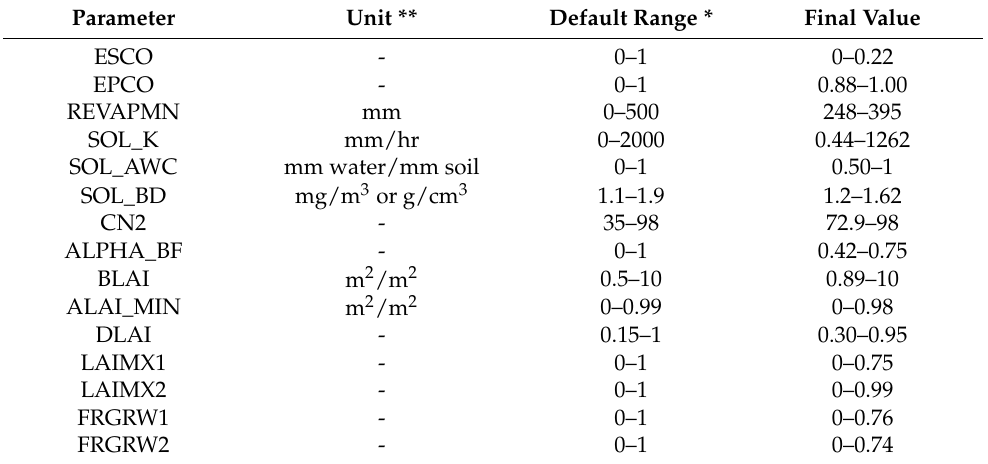
Table 2. Final values of fifteen parameters optimized in SWAT model used to mimic ET and